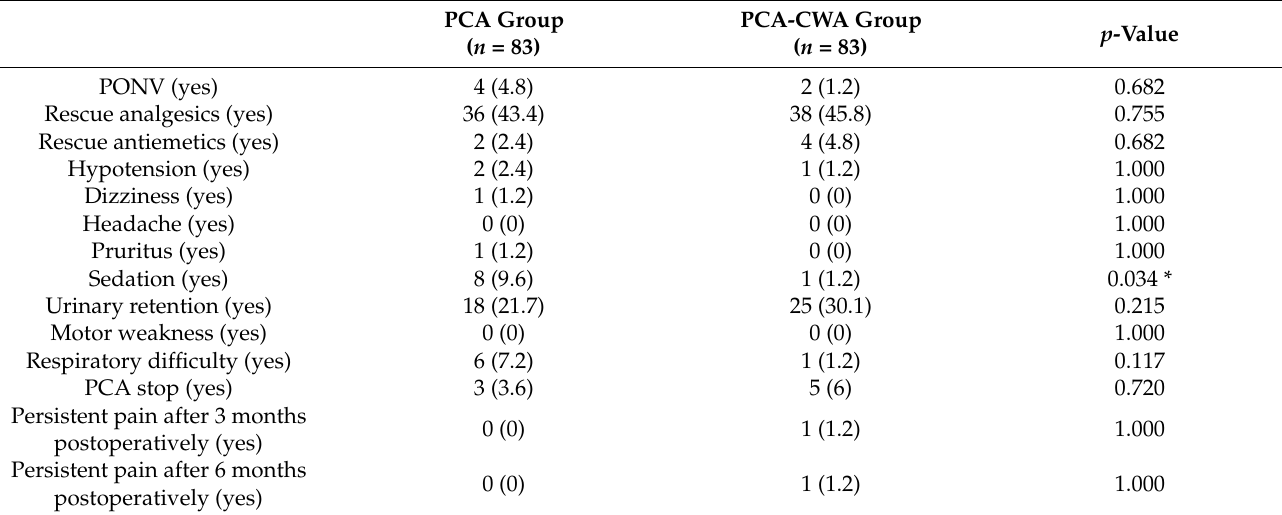
Table 6. Postoperative outcomes after propensity score